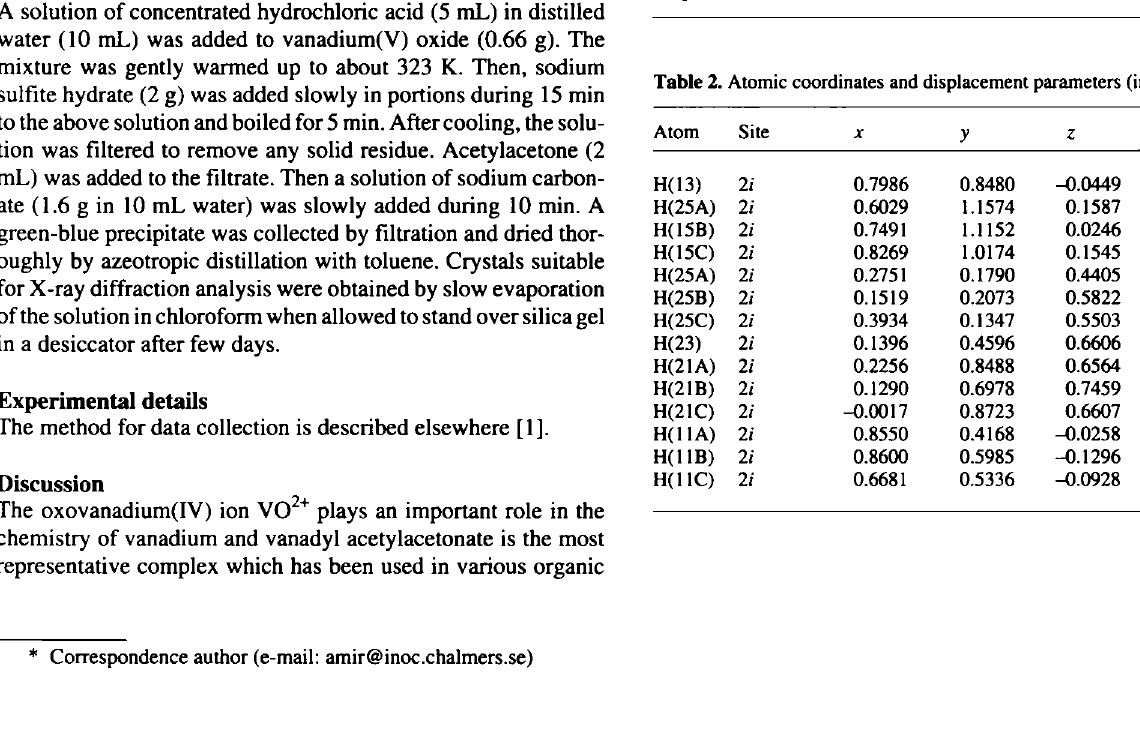
Table 1. Data collection and handling.